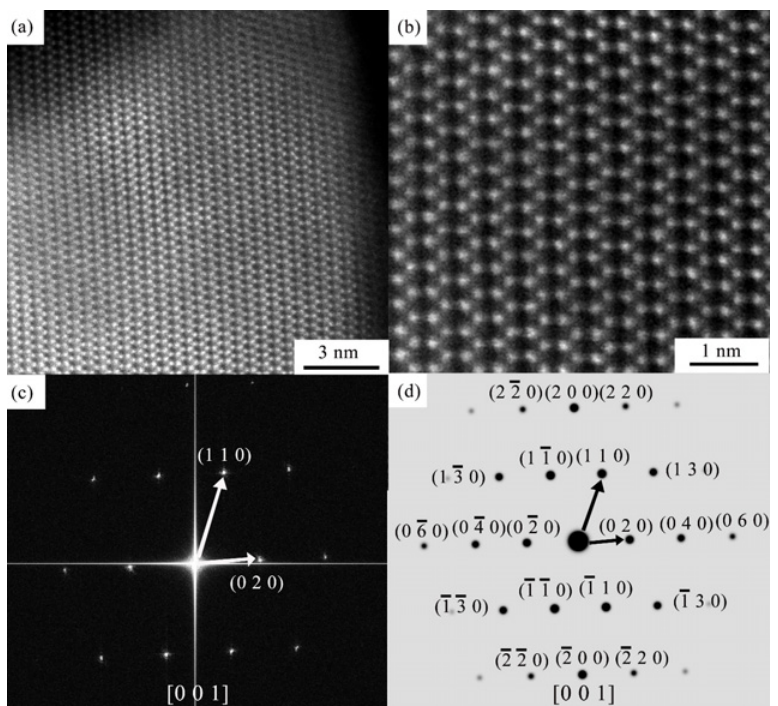
Fig. 11 Atomic-resolution STEM–HAADF images of high-entropy (Mg,Co,Ni,Zn)Ti 2 O 5 at (a) low and (b) high magnifications; (c) corresponding SAED pattern; and (d) simulated pattern of the standard pseudobrookite phase taken from the [001]